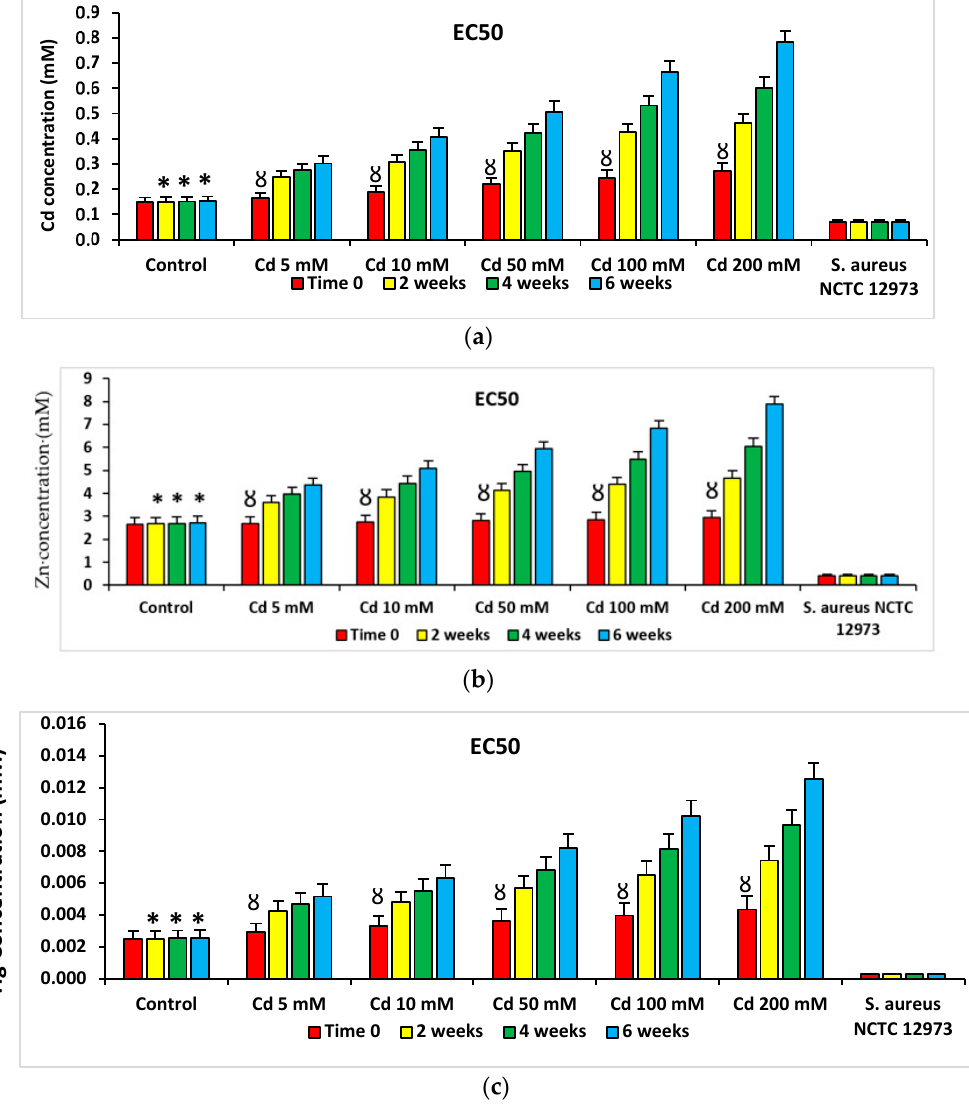
Figure 3. Mean EC50 values of PICT analysis with ( a ) Cd, ( b ) Zn and ( c ) Hg for bacteria from Cd-spiked microcosms. * p < 0.05 compared to Cd, Zn or Hg EC50 values for bacteria from Cd-spiked microcosms at the same time point; Ȣ p < 0.05 compared to Cd, Zn or Hg EC50 values for bacteria from Cd-spiked microcosms at 2, 4 and 6 weeks. Staphylococcus aureus NCTC 12973 was a negative control.